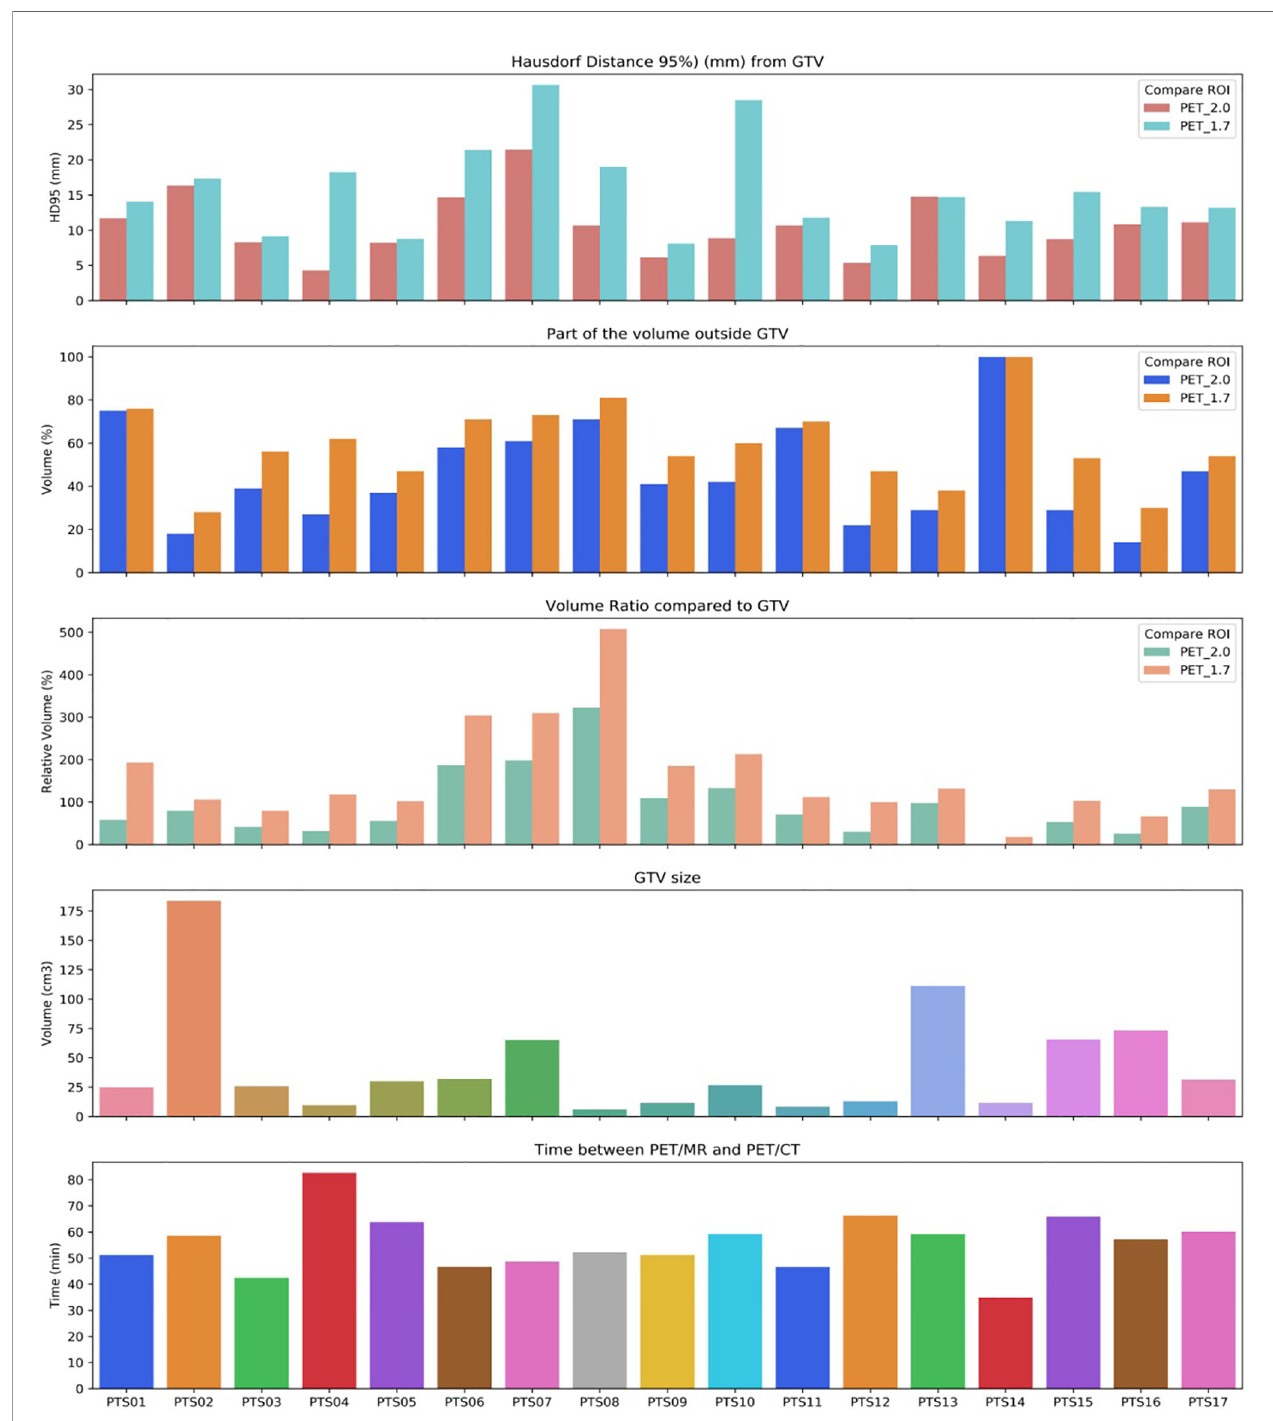
FIGURE 3 | Calculated Hausdorff distance and GTV volume ratios compared to BTV 1.7 and BTV 2.0 volumes and relative GTV size are shown. Time elapsed between PET/MRI and PET/CT scans was also indicated per